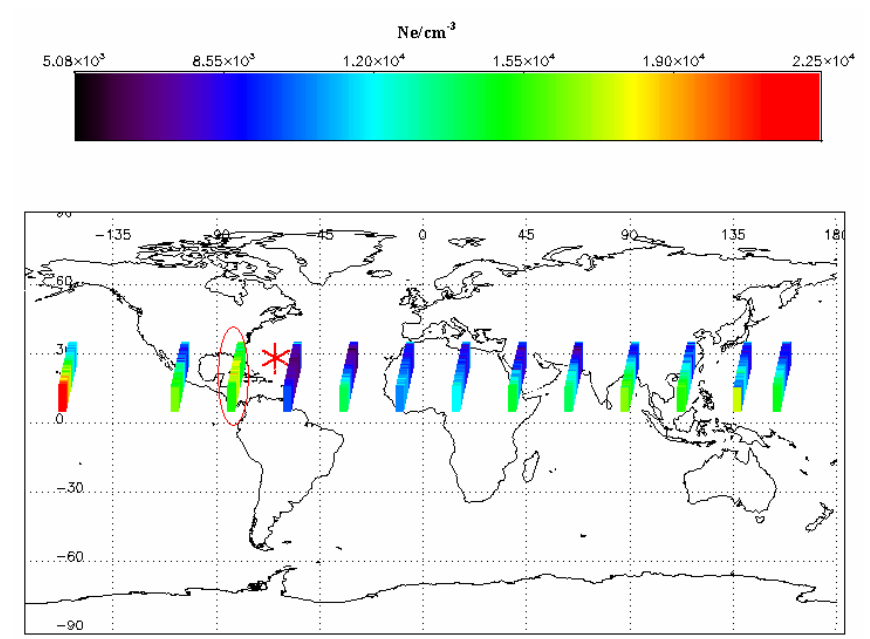
Fig. 4. Electron density distribution around the globe during daytime on 11 January 2010. Star shows the epicenter of the Haiti earthquake.